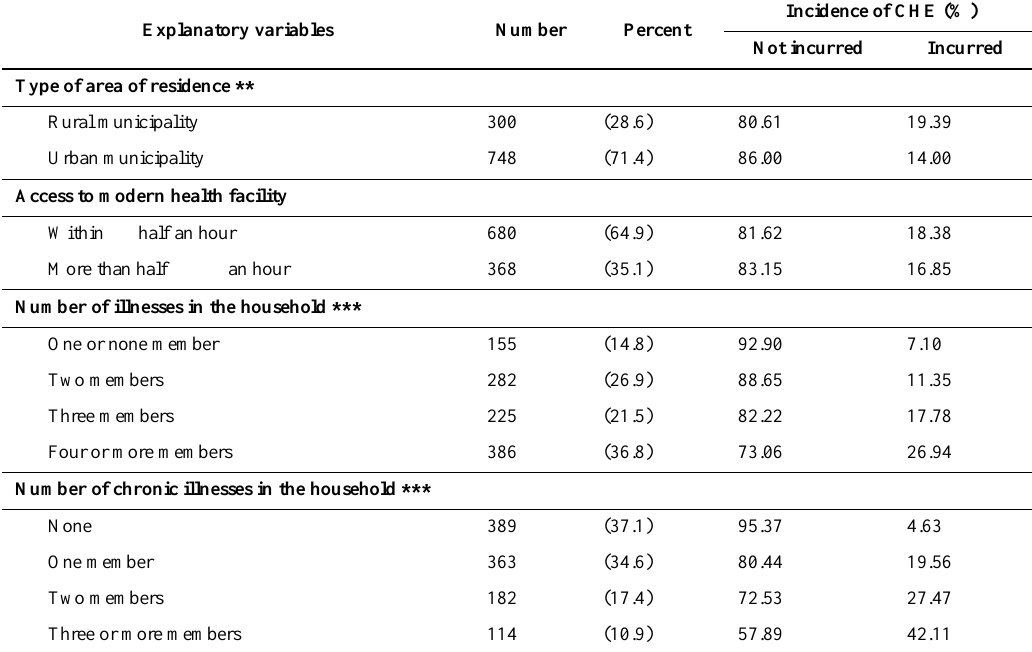
Table 3. Households experiencing CHE according to community and illness